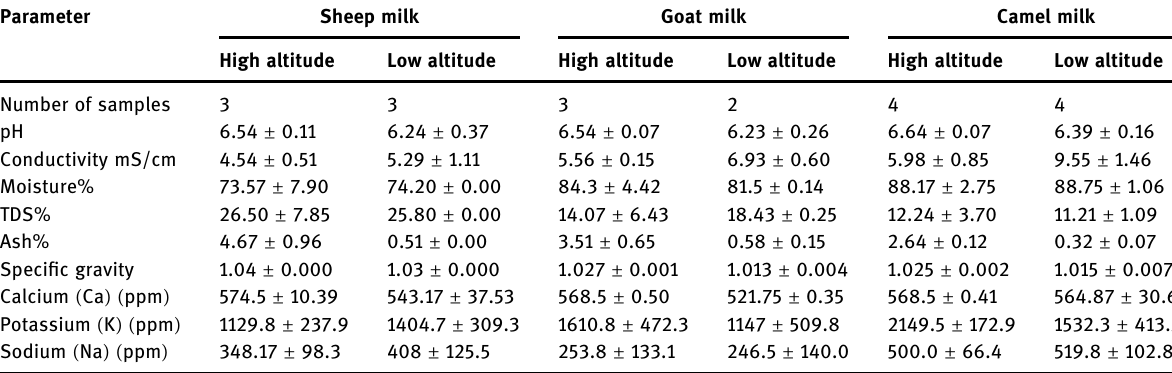
Table 1: The results of the studied parameters ( mean ± SD ) in the milk samples from di ff erent origins and altitudes